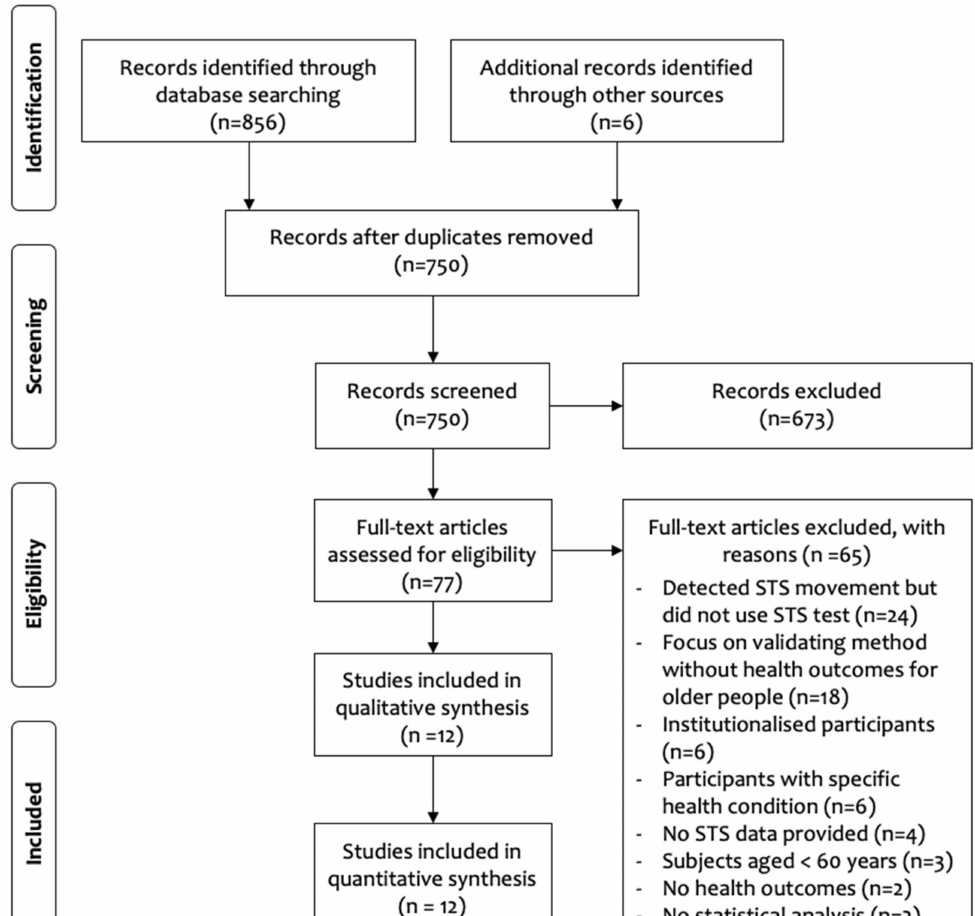
Figure 1. Preferred Reporting Items for Systematic Review and Meta-Analyses (PRISMA) flow chart of study selection